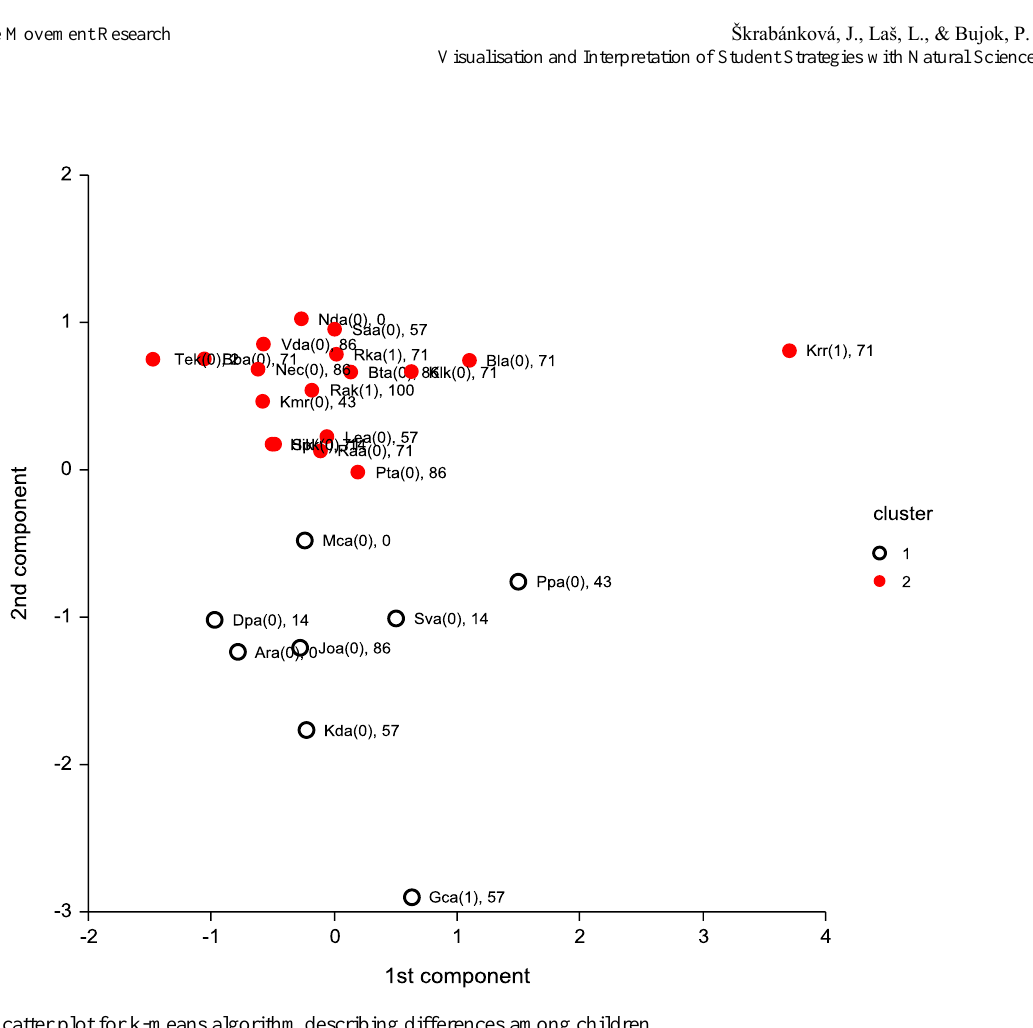
Fig. 4 Scatter plot for k-means algorithm describing differences among